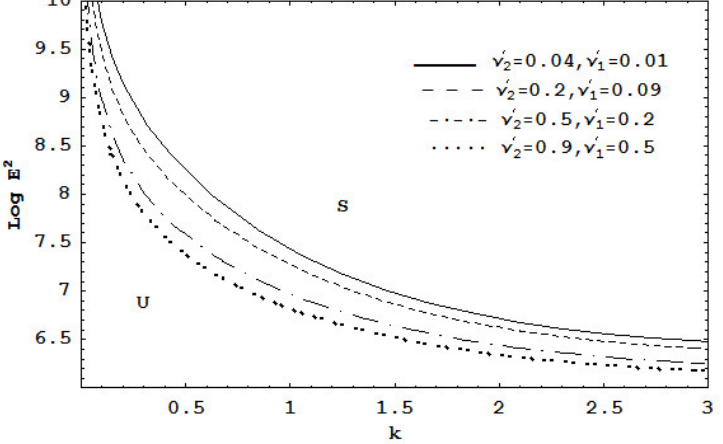
Figure 5. Variation of the electric field intensity log E 2 kinematic viscoelasticities ν (cid:48)